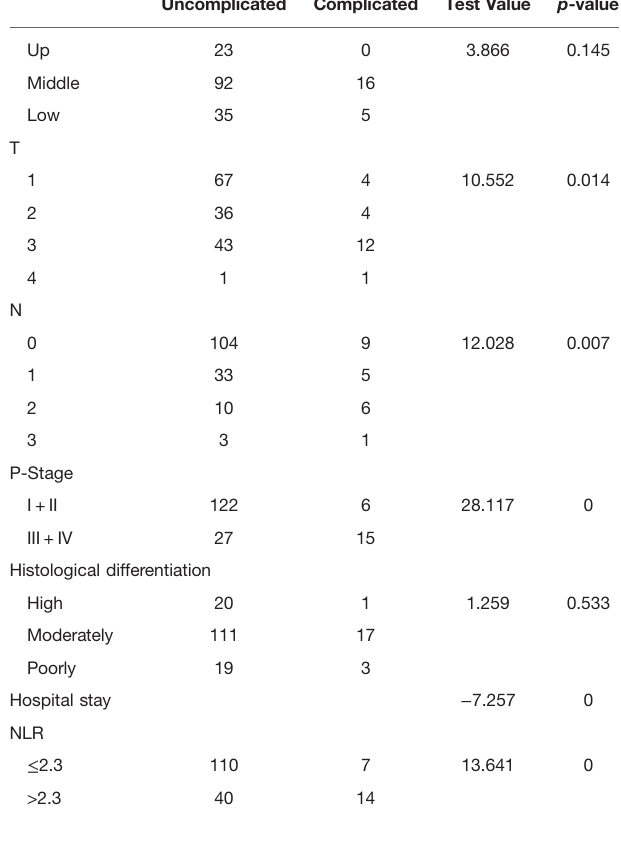
TABLE 2 | Clinicopathologic characteristics in patients undergoing Esophagectomy: MultivariateLogistic Regression